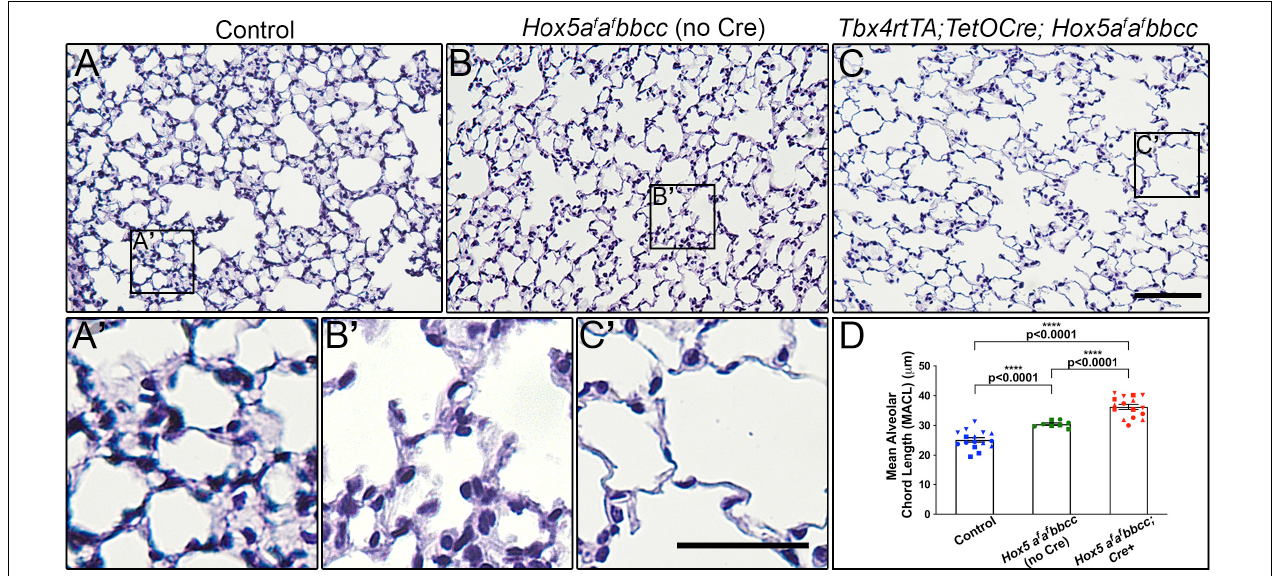
FIGURE 1 | Deletion of Hox5 function at adult stages leads to distal lung airway expansion. H&E sections through 10-week-old wild-type animals (A,A’) , Hox5a f a f bbcc mutants (no Cre) (B,B’) and Hoxa5 LoxP / LoxP ; Hoxb5 - / - ; Hoxc5 - / - ; Tbx4rtTA; TetOCre + mutants ( Hox5a f a f bbcc; Cre +, C,C’ ), treated with Doxycycline from 8 to 10 weeks of age. Measured mean alveolar chord length (MACL) values (D) . Hox5a f a f bbcc double mutant animals ( Hoxa5 floxed alleles with no Cre) exhibit enlarged, simplified alveoli with a ∼ 20% increase in alveolar chord length compared to control lungs. The distal airway expansion phenotype with adult, conditional Hox5 triple mutants increases by ∼ 45% compared to control lungs. Each shape represents an individual animal. Control, Hox5AABBCC . Scale bars: 50 µ m (C) ; 25 µ m (C’) . P -values and statistical significance (**** P < 0.0001) were determined by an unpaired Student’s t -test.